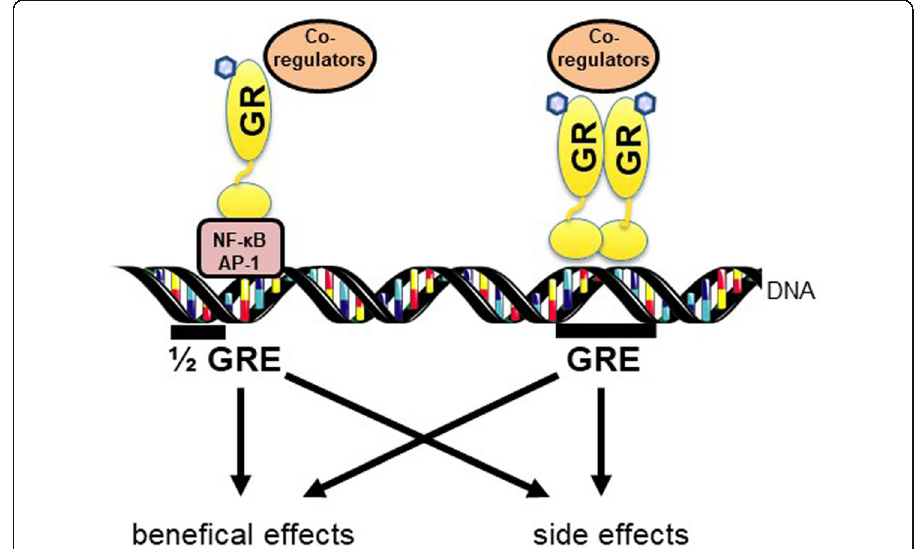
Fig. 3 The classical dogma that the glucocorticoid receptor (GR) monomer by interaction with pro- inflammatory transcription factors with AP-1, NF- κ B, or half glucocorticoid response elements (1/2